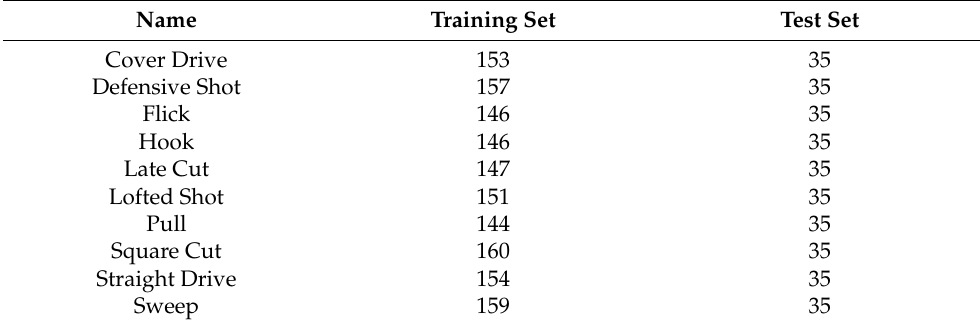
Table 6. Dataset video quantity for 10 cricket batting